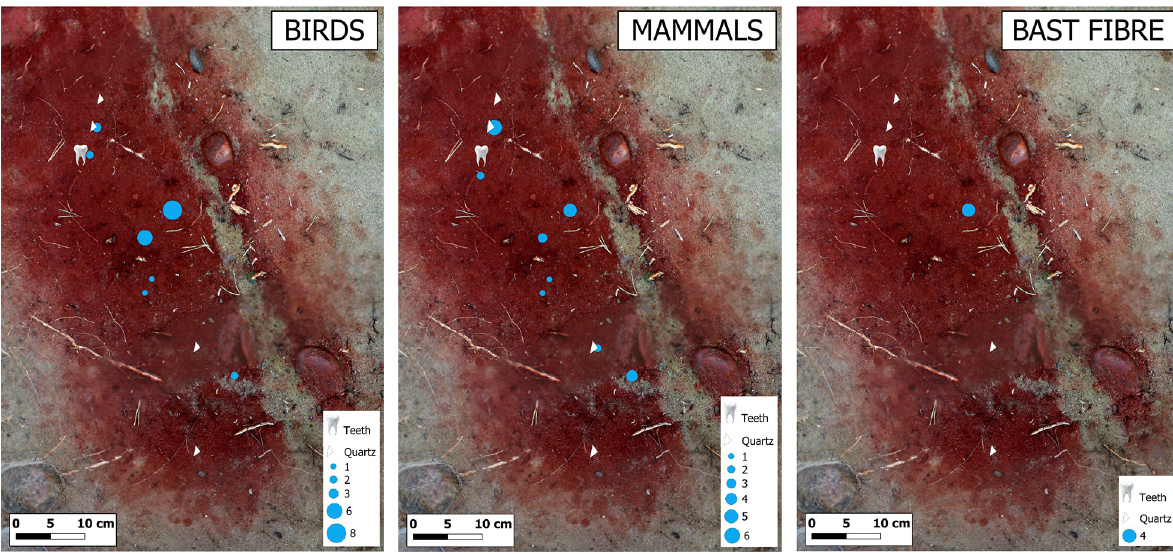
Fig 5. The distribution of A) bird barbules, B) mammalian hairs and C) bast fibers in the soil samples. Background map: Orthophoto of the photogrammetry 3D model: Jan-Erik Nyman, Esa Mikkola and Janne Rantanen, Finnish Heritage Agency. Drawing: Johanna